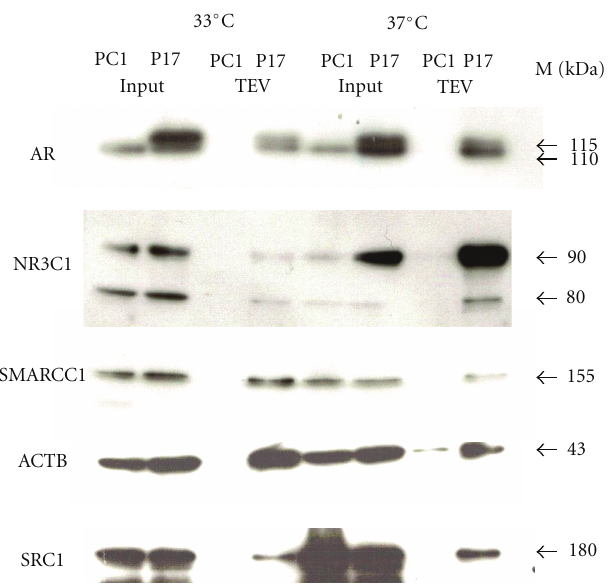
Figure 4: AR interacting proteins SMARCC1 and NR3C1 are di ff erentially expressed in proliferating versus nonproliferating P17 cells. Western blot analysis of known AR coregulators identified by mass spectrometry only in AR FLAG copurifications from proliferating P17 cells (SMARCC1) and of a known coregulator identified by mass spectrometry only in AR FLAG copurifications from nonproliferating P17 cells (NR3C1). SRC1 was not identified at all, neither in purifications from proliferating nor nonproliferating P17 cells. AR and ACTB were identified in both FLAG copurifications from P17 cells by mass spectrometry. Compared to the other identified known AR interacting proteins NR3C1, SMARCC1, and ACTB, a smaller portion of the total SRC1 present in the nuclear extract (P17 Input) interacts with AR (P17 TEV). M is the size estimate by a prestained protein ladder in kilo Daltons